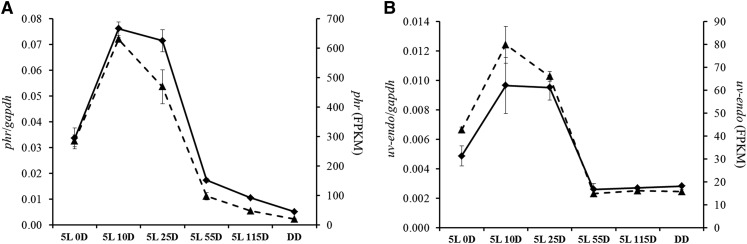
Validation of mRNA-Seq data for the (A) phr (MAC_05491) and (B) uv-endo (MAC_07337) genes with quantitative reverse transcription PCR (qRT-PCR). Solid lines refer to qRT-PCR (primary y-axis) and dashed lines refer to mRNA-Seq data (secondary y-axis). Error bars are standard deviation from three independent experiments.